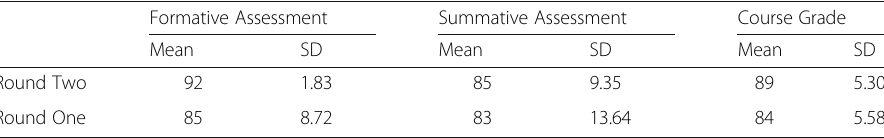
Table 3 Participants ’ Learning